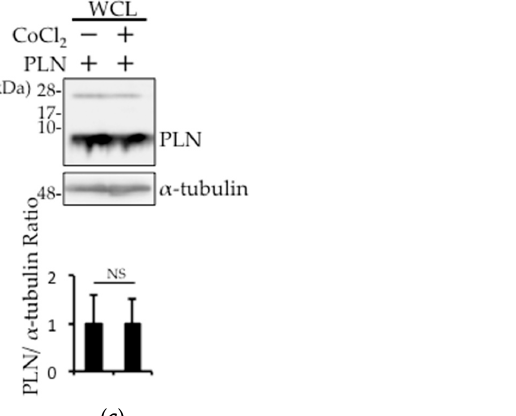
increased with or without H 2 O 2 treatment in siVHL-transfected HEK293 cells (Figure 4a,b). HA-mock vector (control) (Figure S2) or siControl (Figure 4c) did not change the VHL expression level. In cells (Figure 4c). Isoproterenol-induced PLN reduction was not recovered with 50 ug/mL cycloheximide (CHX), an inhibitor of protein synthesis, indicating that the isoproterenol-induced PLN reduction may be due to the acceleration of PLN degradation (Figure S3).